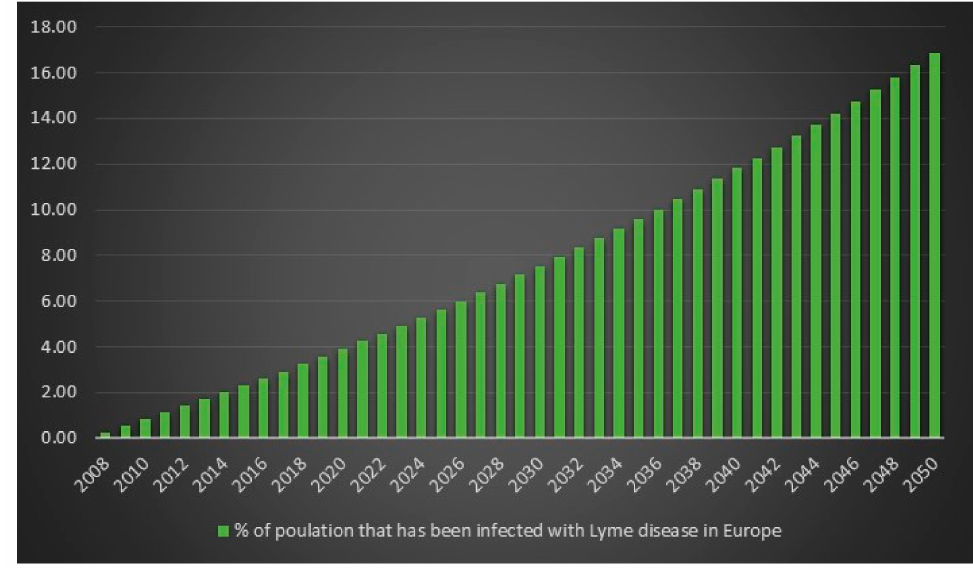
Figure 16. % of the population in Europe that have been infected with Lyme disease between the years 2008 to 2050.